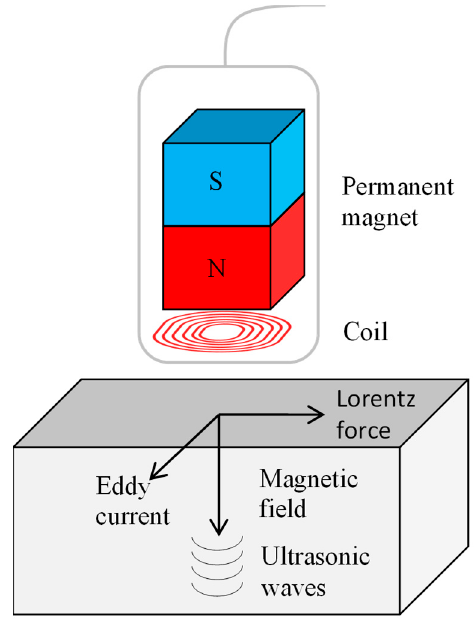
Figure 19 . Working principle EMAT . Figure 19. Working principle